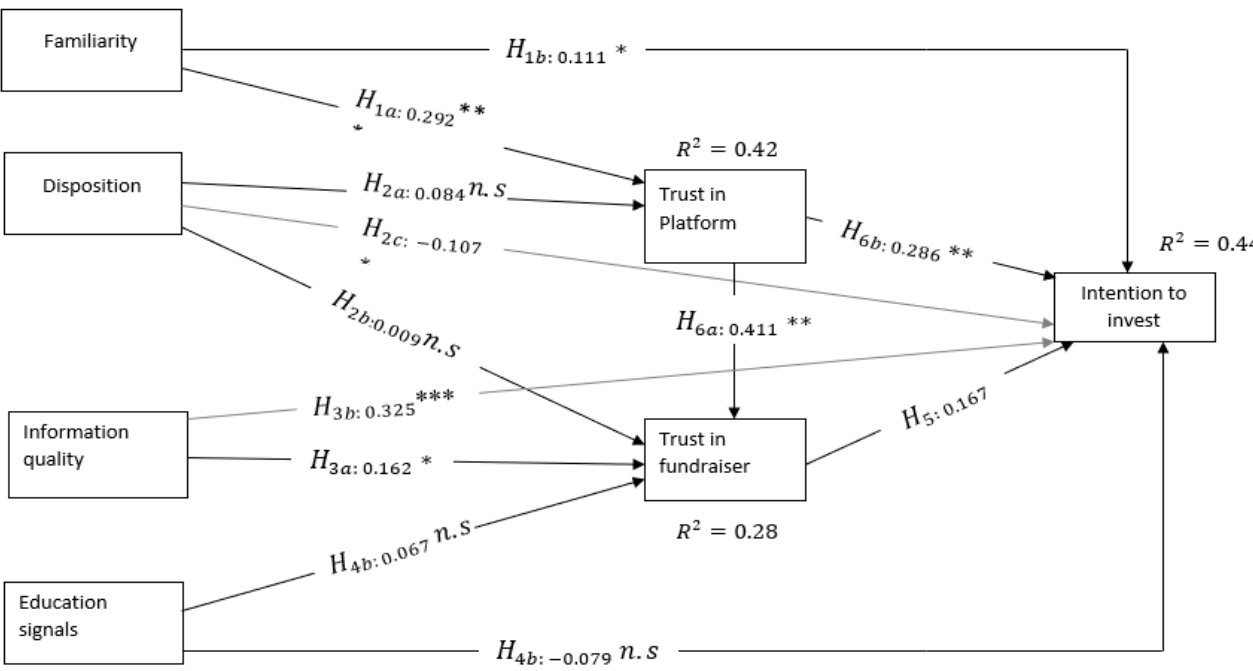
Figure 2. Visual representation of the tested SEM model. Note: n.s., not significant. p < 0.05 *; p < 0.01 **; p < 0.001 ***. We started with the direct effect of familiarity on trust in the platform, shown by H1a. The results showed that familiarity significantly influenced trust in the platform ( b = 0.29,